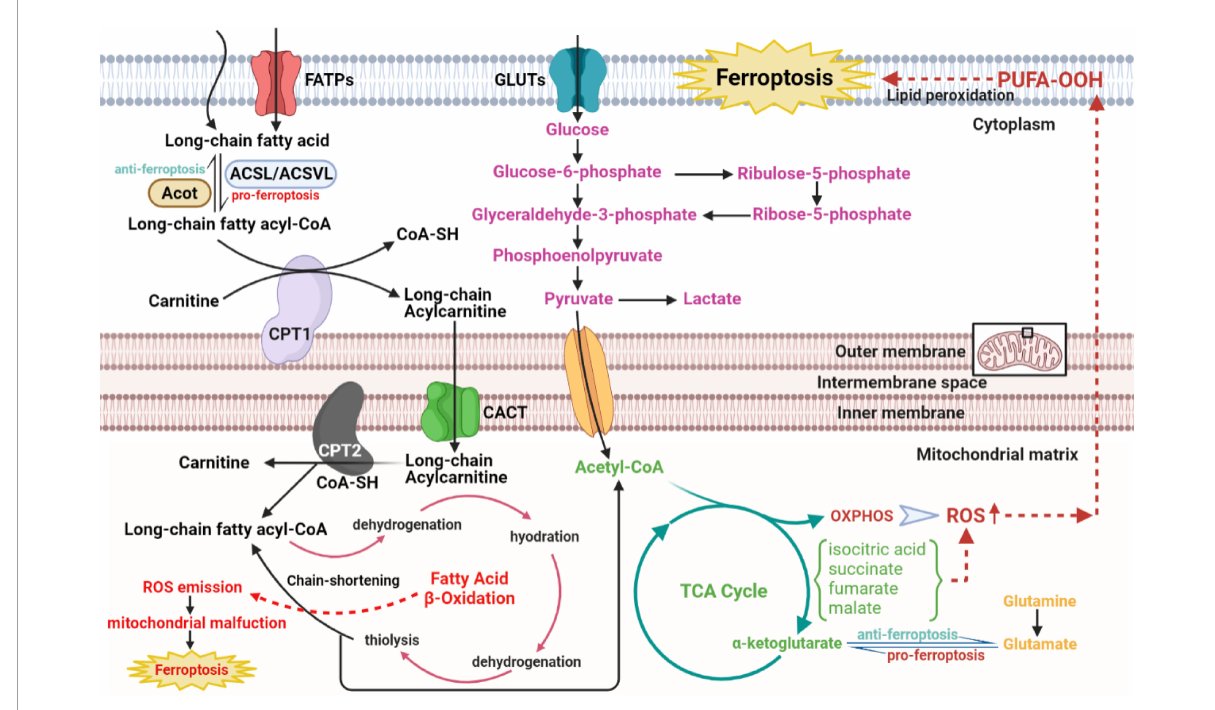
FIGURE4 The role of glucose and fatty acid metabolic disorders in the regulatory network of ferroptosis of CVDs. The long-chain fatty acid is activated and transformed into long-chain fatty acyl-CoA with the catalytic activity of ACSL/ACSVL. The long-chain fatty acyl-CoA combines with carnitine and enters fatty acid β -oxidation in the mitochondrial matrix with help of CPT1, CPT2, and CACT. Then acetyl-CoA from the β -oxidation cycle, anaerobic glycolysis, and glutaminolysis gather to strengthen the metabolism of the TCA cycle in mitochondrial matrix, which activates downstream OXPHOS and ROS, eventually resulting in cellular ferroptosis. CVDs, cardiovascular diseases; ACSL, long-chain acyl-CoA synthases; ACSVL, very long-chain acyl-CoA synthases; CoA, coenzyme A; CPT1, carnitine palmitoyltransferase1; CPT2,